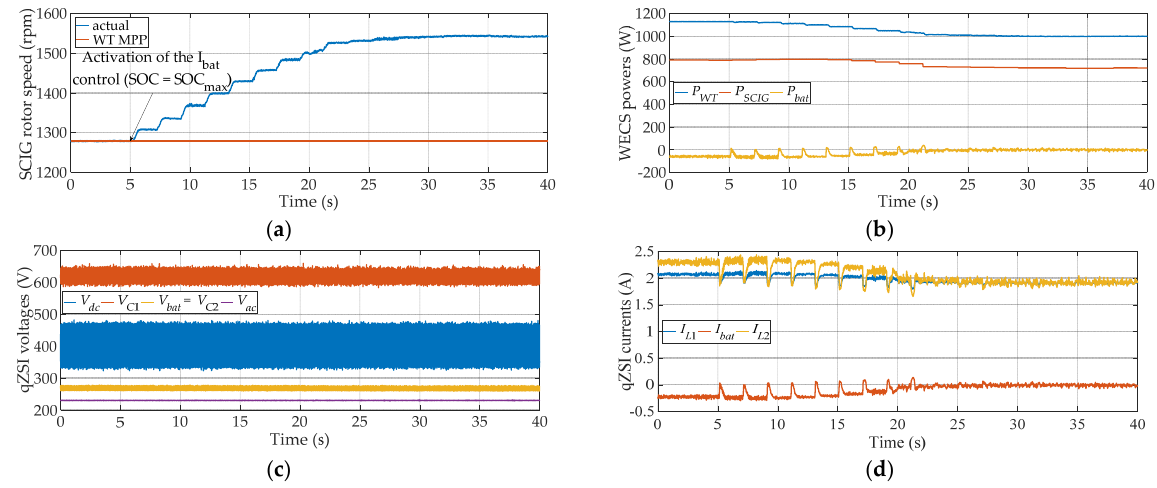
Figure 13. Dynamic responses for the case of maximum SOC: ( a ) SCIG rotor speed; ( b ) WECS powers; ( c ) qZSI voltages; ( d ) qZSI currents.